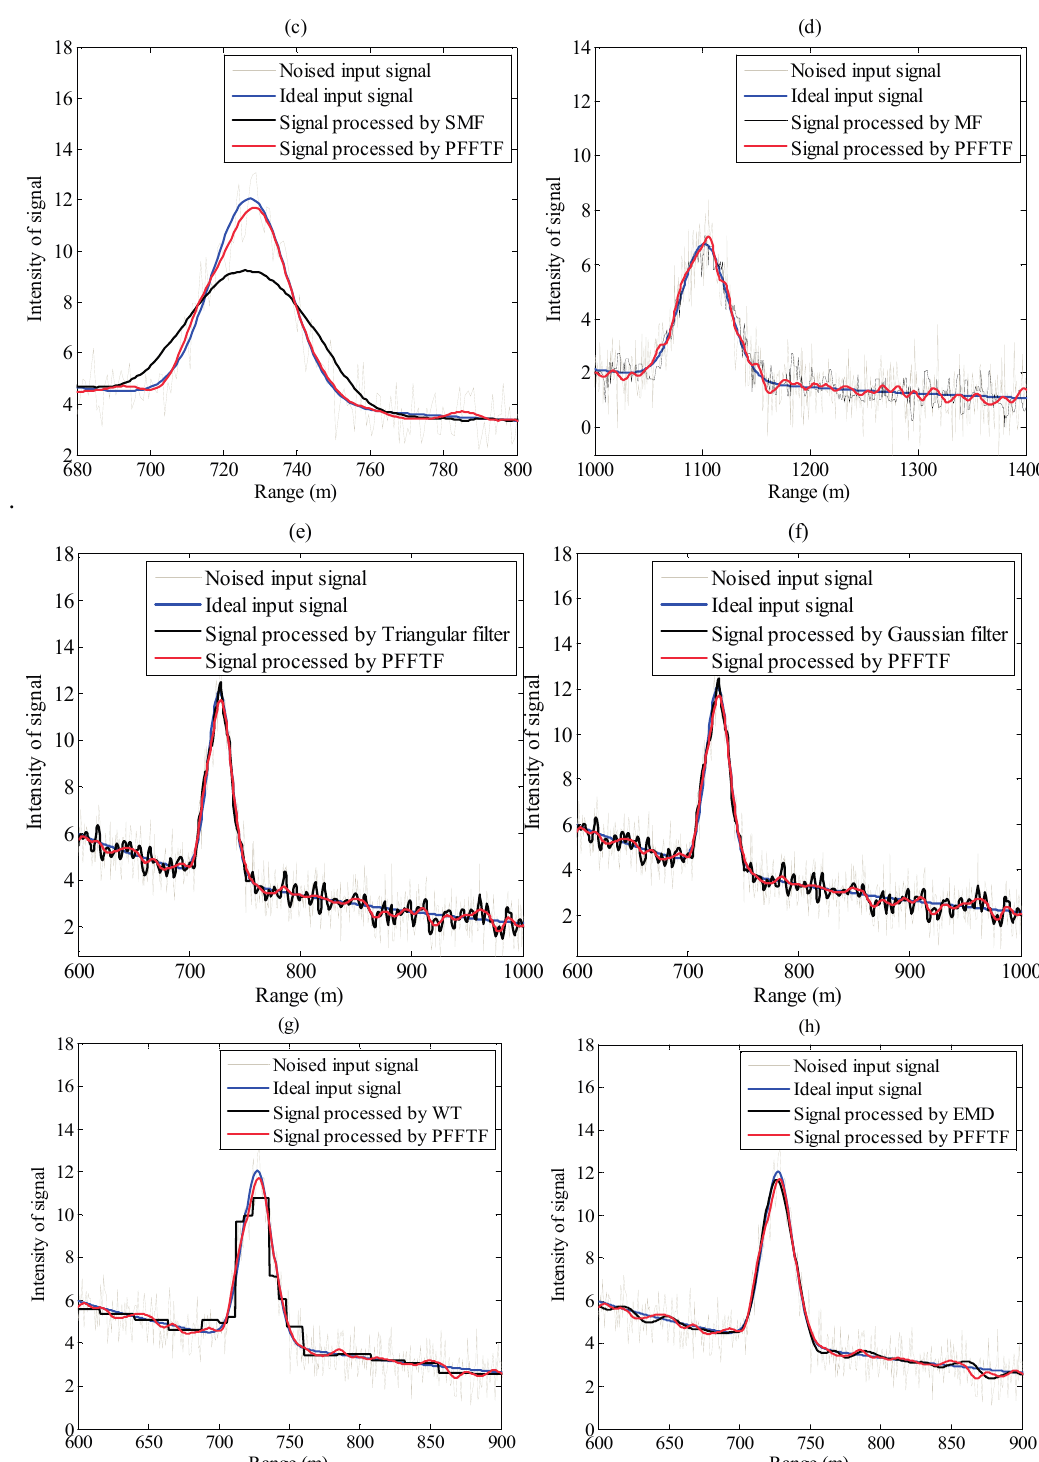
Figure 5. Comparison of different methods. ( a ) Comparison among ideal signal, noised input signal and signal processed by PFFTF; ( b ) Comparison between TLPF and PFFTF; ( c ) Comparison between SMF and PFFTF; ( d ) Comparison between MF and PFFTF; ( e ) Comparison between triangular filter and PFFTF; ( f ) Comparison between Gaussian filter and PFFTF; ( g ) Comparison between WT and PFFTF; ( h ) Comparison between EMD and